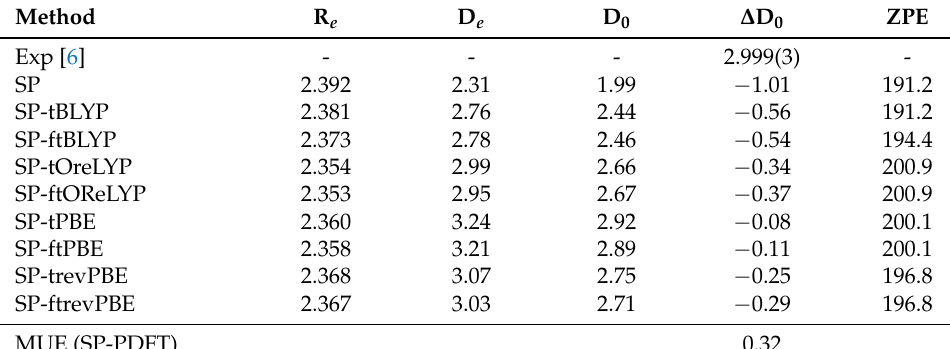
Table 11. Dissociation energies (eV), equilibrium bond lengths (Å), and zero point energies (in cm − 1 ) for TaSi in the 4 Π molecular state, computed with a SP wave function.